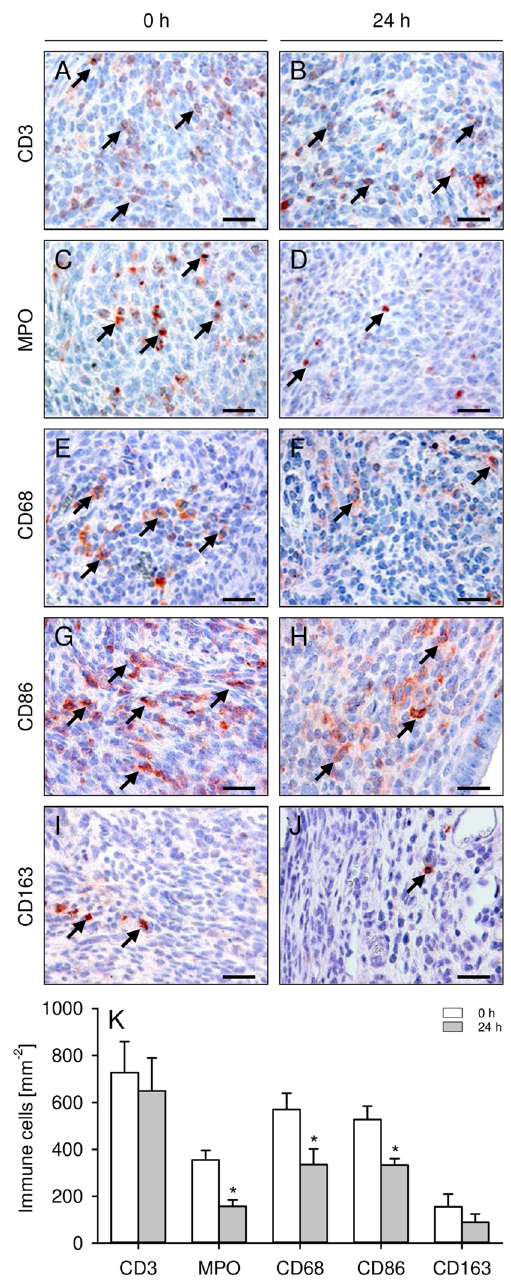
Figure 6. ( A – J ) Immunohistochemical detection of CD3 + lymphocytes ( A , B ; arrows), MPO + neutrophilic granulocytes ( C , D ; arrows), CD68 + macrophages ( E , F ; arrows), CD86 + M1 macrophages ( G , H ; arrows) and CD163 + M2 macrophages ( I , J ; arrows) in endometriotic lesions on day 28 after transplantation of freshly isolated (0 h; A , C , E , G , I ) and 24-h-precultivated ( B , D , F , H , J ) uterine tissue samples from C57BL/6- TgN(ACTB-EGFP)1Osb/J donor mice to the peritoneal wall of C57BL/6J recipient mice. Scale bars: 25 µm. ( K ) CD3 + lymphocytes (mm −2 ), MPO + neutrophilic granulocytes (mm −2 ), CD68 + macrophages (mm −2 ), CD86 + M1 macrophages (mm −2 ) and CD163 + M2 macrophages (mm −2 ) in endometriotic lesions on day 28 after transplantation of freshly isolated (0 h; white bars; n = 10) and 24-h-precultivated (grey bars; n = 6) uterine tissue samples from C57BL/6-TgN(ACTB-EGFP)1Osb/J donor mice to the peritoneal wall of C57BL/6J recipient mice. Mean ± SEM; *P < 0.05 vs. 0